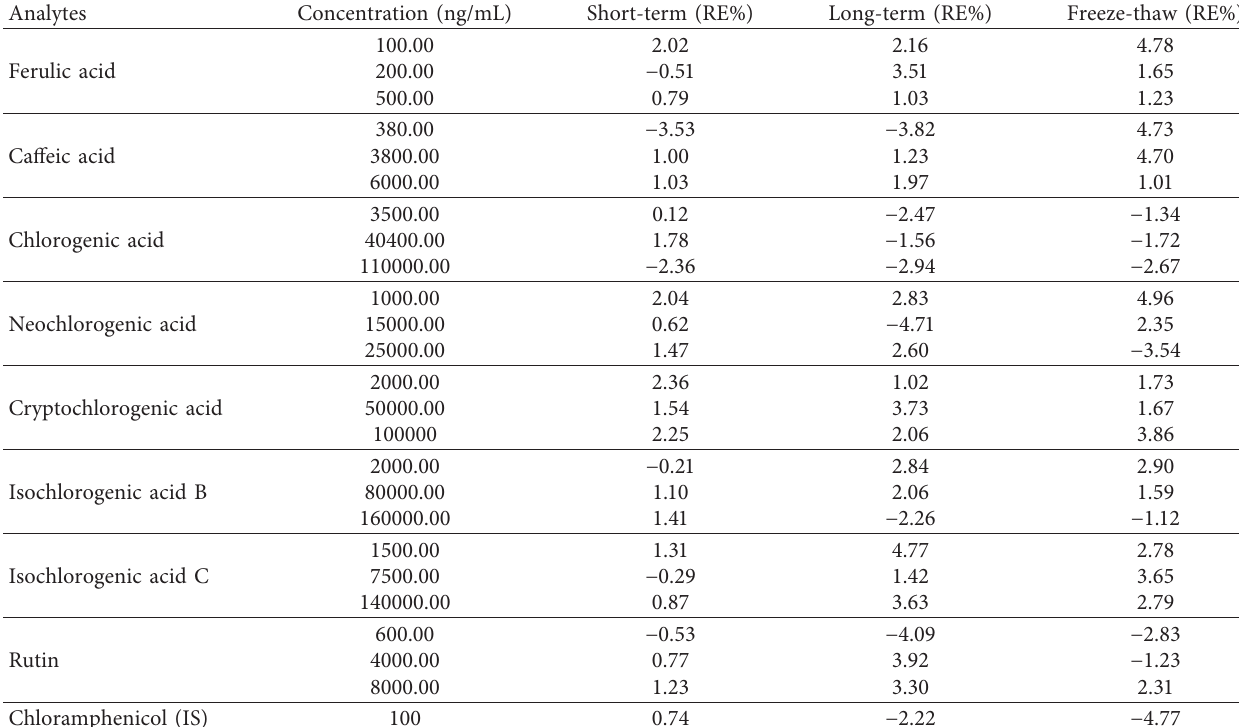
Table 5: Stability of 8 analytes and IS in rat plasma ( n � 3).